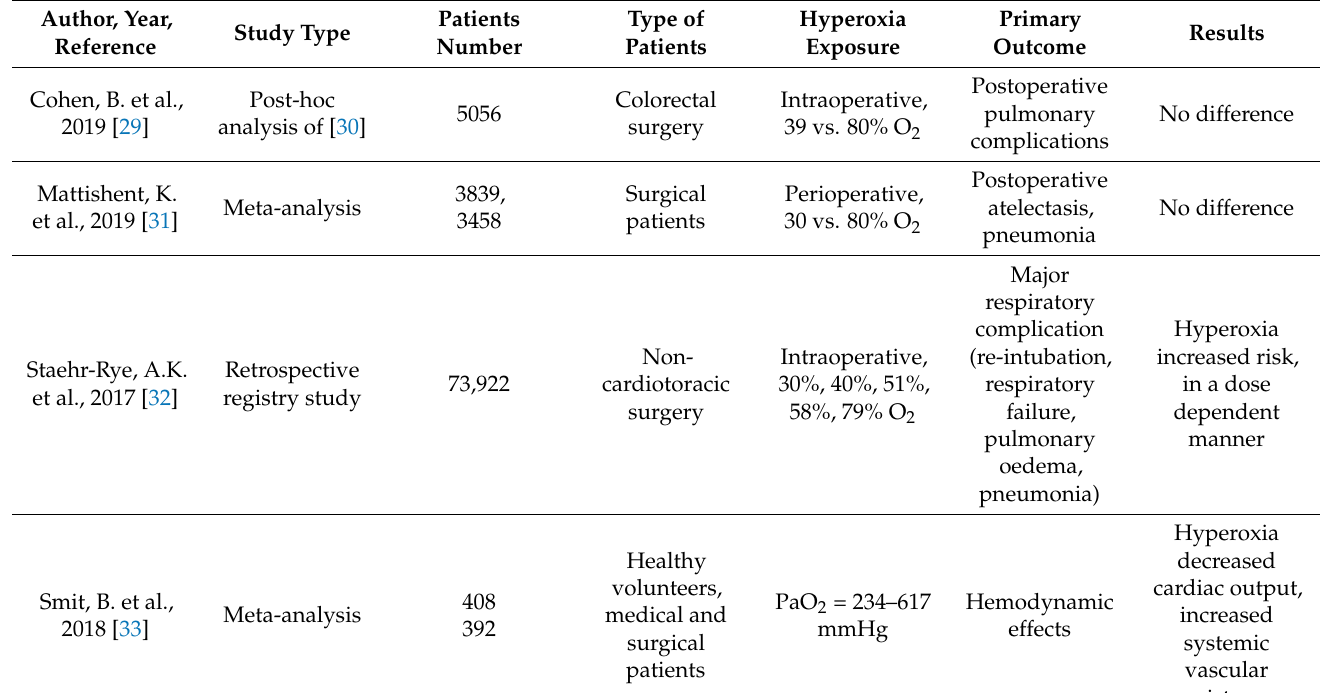
Table 1. Clinical studies exploring hyperoxia exposure effects during the perioperative period in surgical